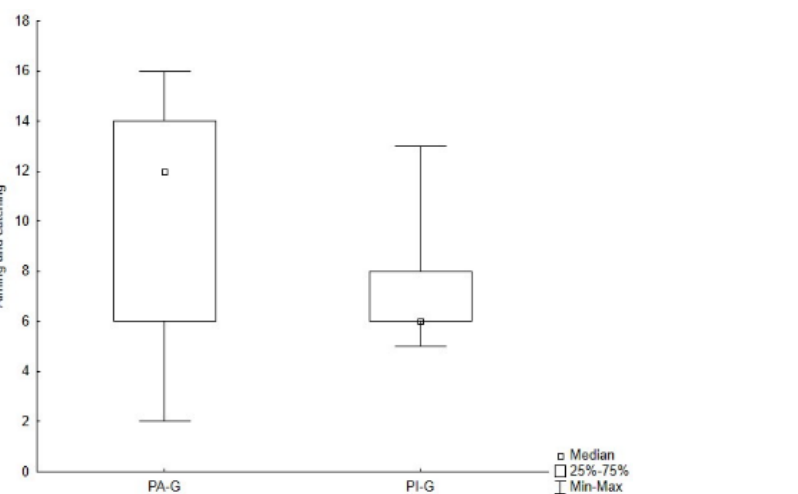
Figure 5. Difference in global motor coordination of the M-ABC between groups. Legend. PA-G, Physically Active Group; PI-G, Physically Inactive Group.